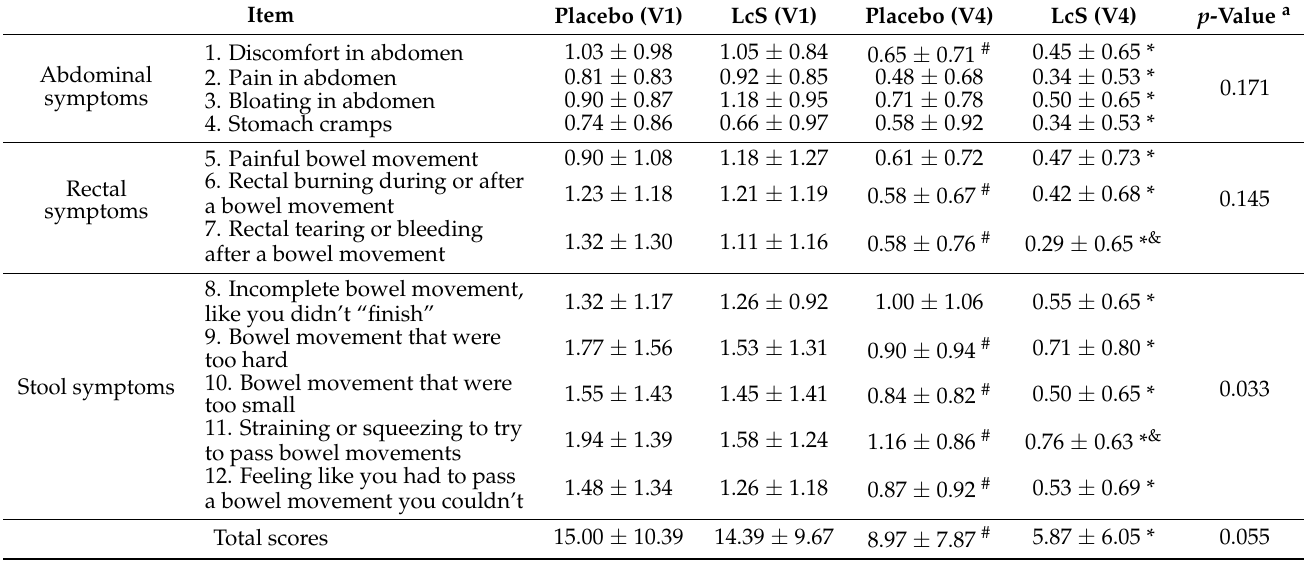
Table 2. The effects of LcS supplementation on patient assessments of constipation-symptom (PAC-SYM) scores.